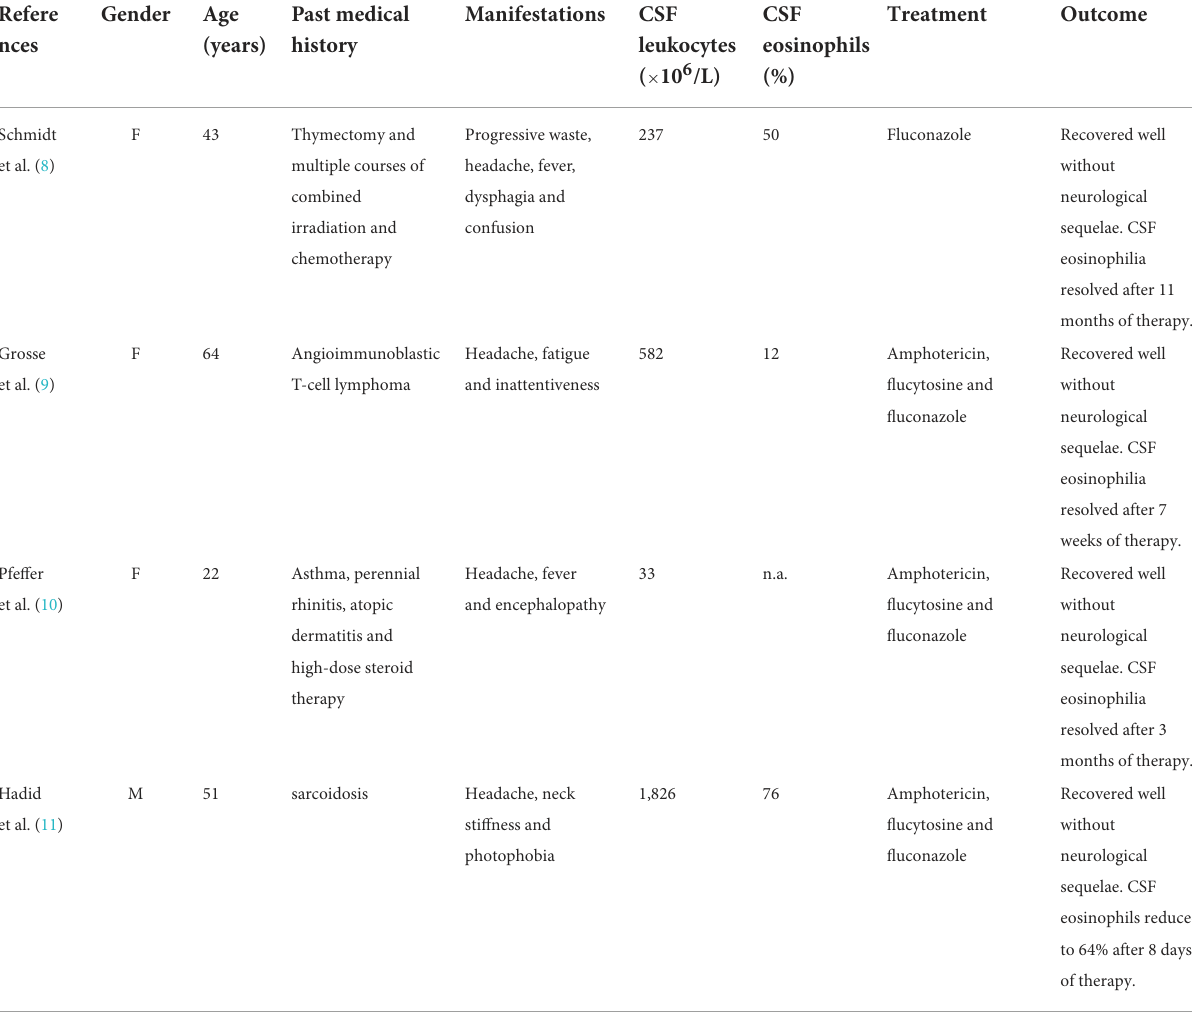
TABLE 1 Summary of the clinical cases of cryptococcal meningitis with CSF eosinophilia published in the last 30